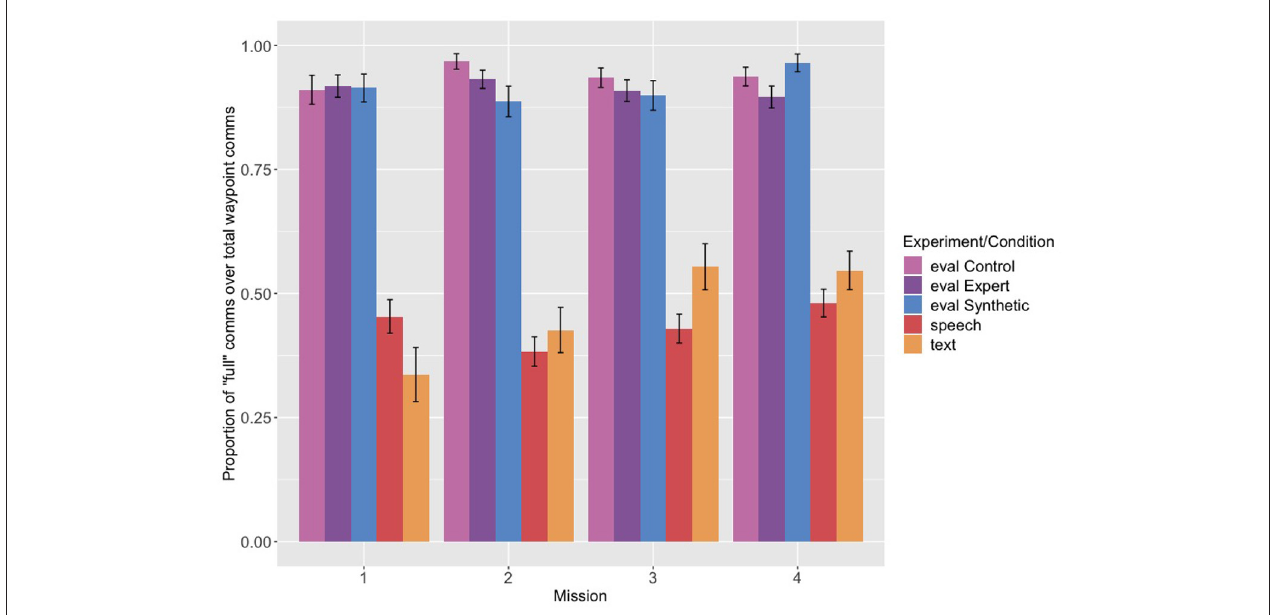
FIGURE 2 | Proportion of “full” communications out of the total of full and partial communications, across the first four missions from each experiment. Eval refers to the evaluation experiment and its related conditions (control, expert pilot, and synthetic teammate pilot), speech to the speech only experiment, and text to the text